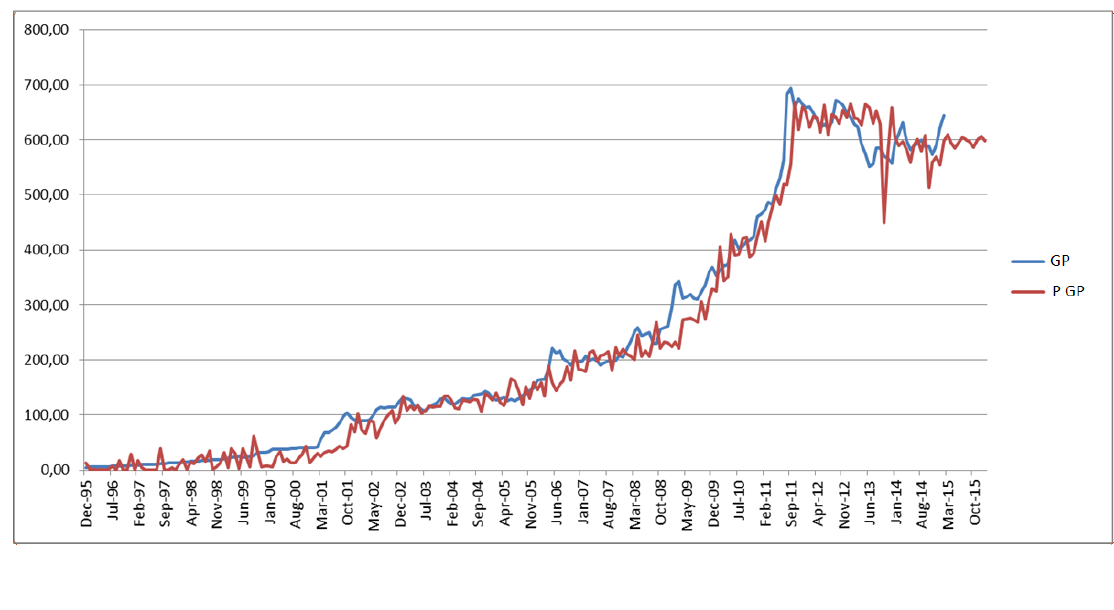
Figure 5. The comparison between the actual values (GP) and the predicted values (P GP) obtained by the second ANN